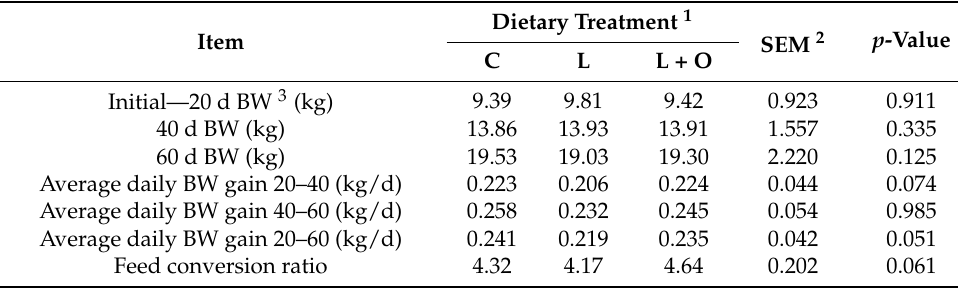
Table 4. Effect of diet on in vivo performances of lambs *.